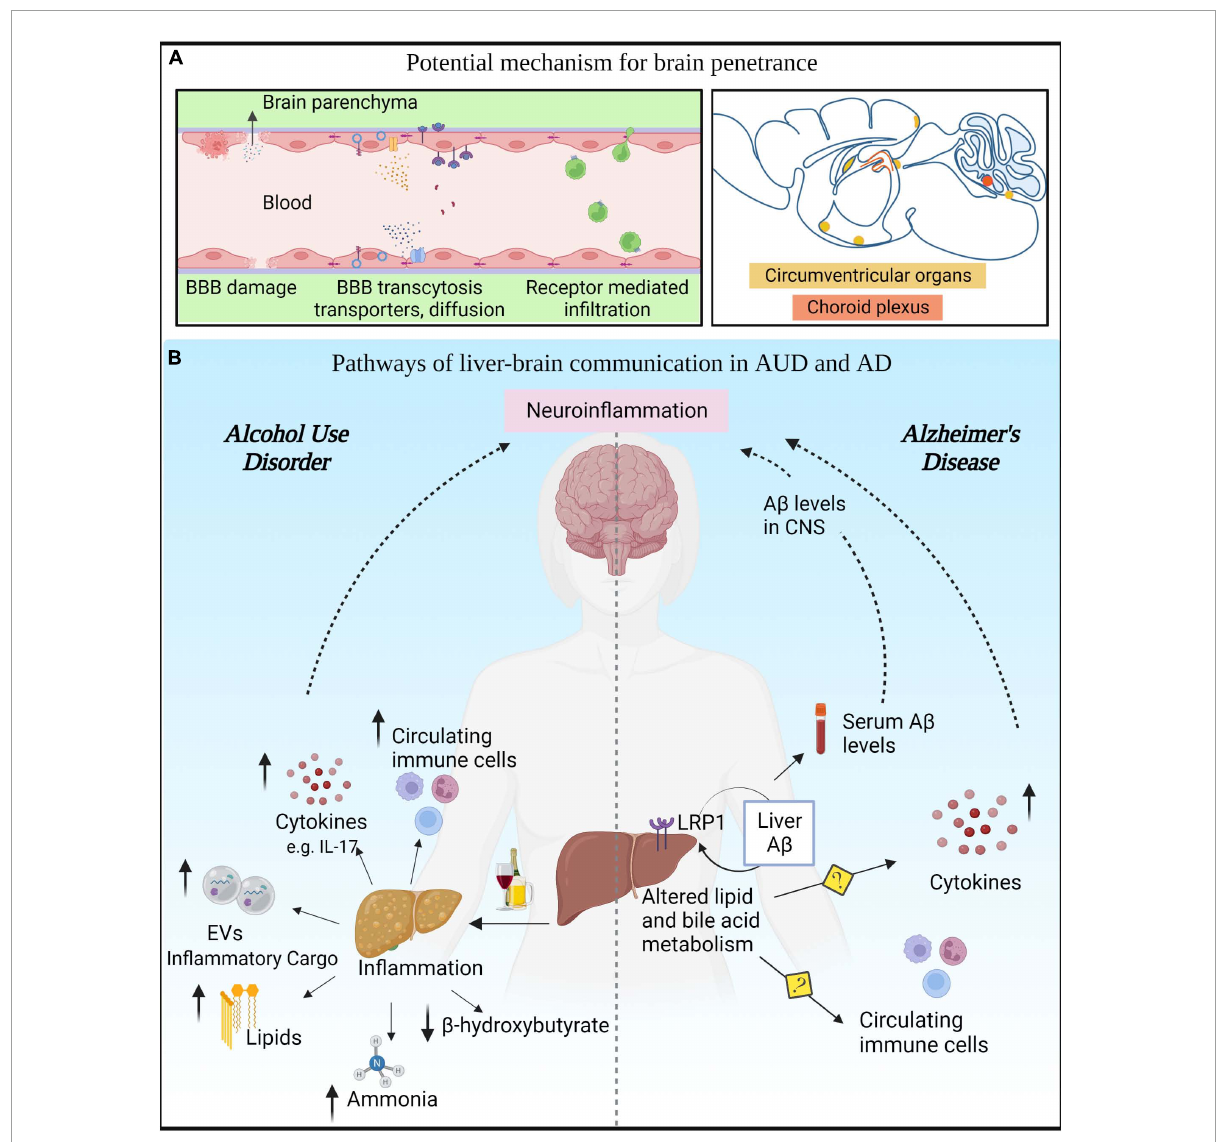
FIGURE2 Liver-brain axis in alcohol use disorder (AUD) and Alzheimer’s disease (AD). (A) Various modes of communication between the peripheral circulation and the brain. (B) AUD leads to innate immune activation in liver that results in secretion of cytokines, chemokines, toxic lipids, EVs, and hepatotoxins in the circulation that can reach the CNS. In AD, altered liver metabolism of lipids and bile acids can modulate A β levels in the periphery and consequently in the